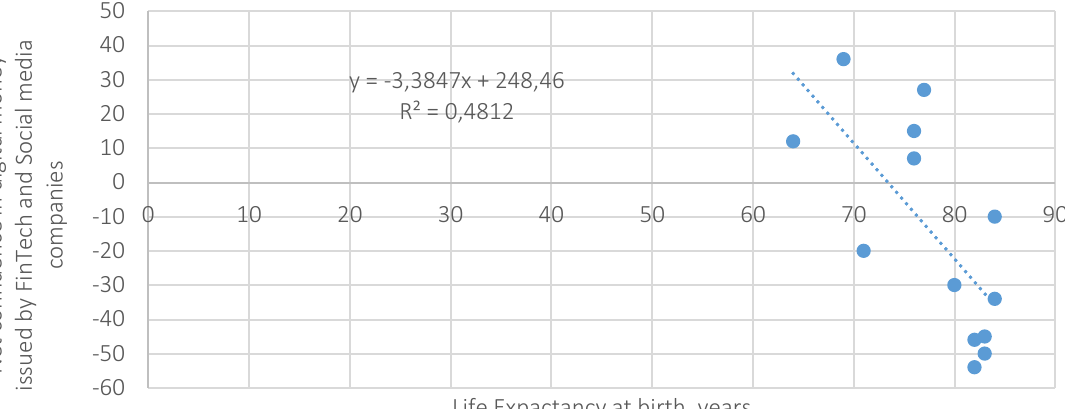
y = -3,3847x + 248,46 R² = 0,4812